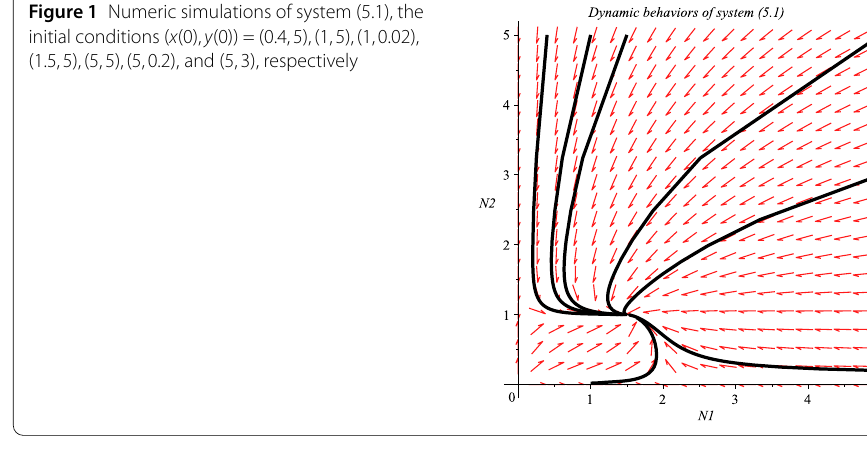
Figure 2 Numeric simulations of system (5.2), the initial conditions ( x (0), y (0)) = (0.4,5),(5,1),(5,3),(5,5), and (5,0.2),